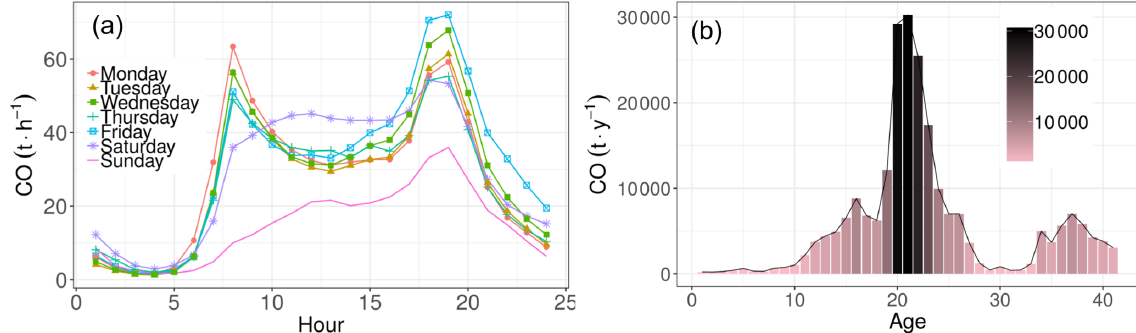
Figure 6. (a) CO emissions (gh − 1 ) per hour of the day and day of the week (colored and shaped lines) for LDV from MASP; (b) CO emissions (tyr − 1 ) according to the age of use of the LDV from MASP.